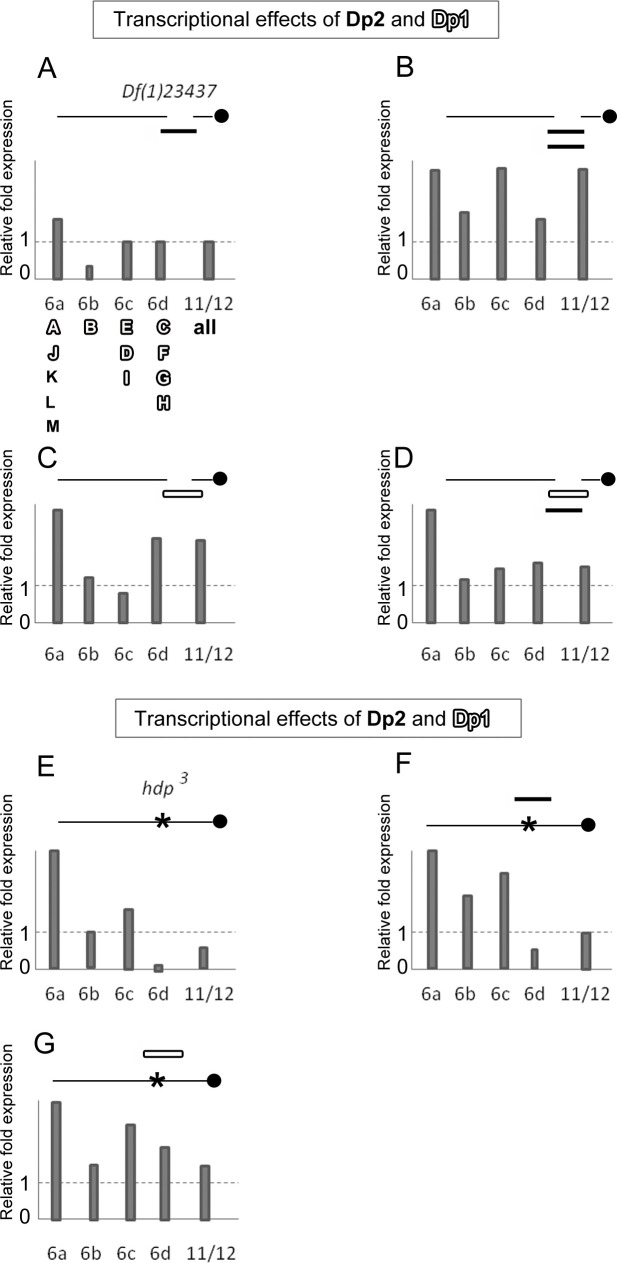
Transcriptional effects of duplications Dp1 and Dp2 covering wupA region. A-D) Effects on l(1)23437 background.We tested the transcriptional efficiency of these two duplications using exon 6 specific primers in qRT-PCR assays on severe hypomorph (23437) males. The wupA transcripts identified by each exon-specific primer are indicated in A. Dotted line indicates the normalized levels of controls. Note that one dose of fosmid (Dp2) fails to produce normal levels of isoform B and two doses do not duplicate linearly the transcription of all isoform. A similar transcriptional heterogeneity is observed with Dp(1;2R)CH322-143G12r (Dp1) in one dose or in combination with Dp2. E-G) Effects on hdp3
background. The same heterogeneity is detected on this background. Note, however, that, in general, the transcriptional efficiency of Dp1 is higher than that of Dp2. This is consistent with the rescue data shown in Table 2.